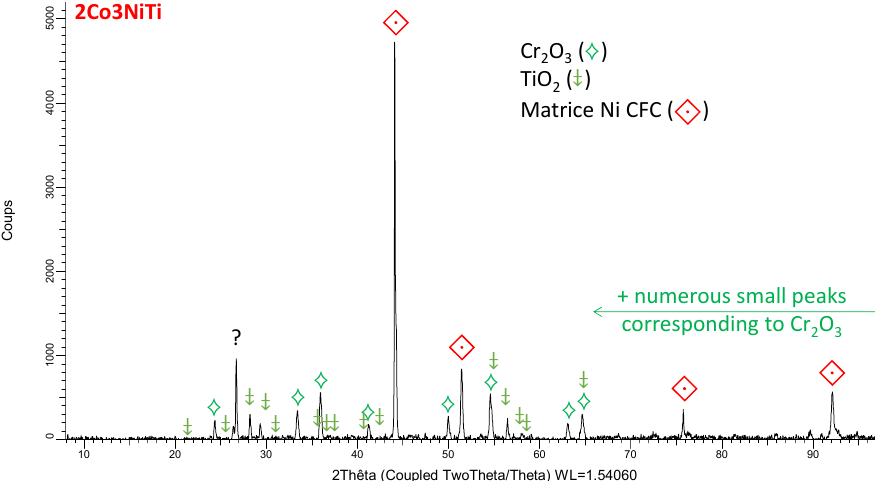
Figure 5. Diffractogram acquired on one side of the oxidized 2Co3NiTi sample.